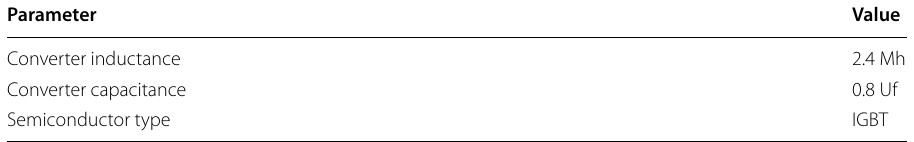
Table 6 Parameters of the bidirectional converter